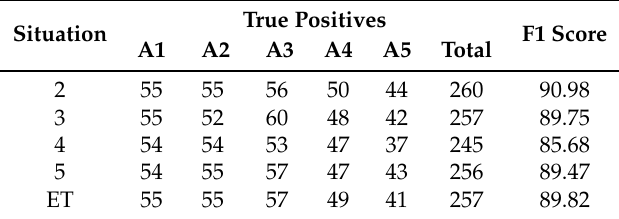
Table 13. Majority vote